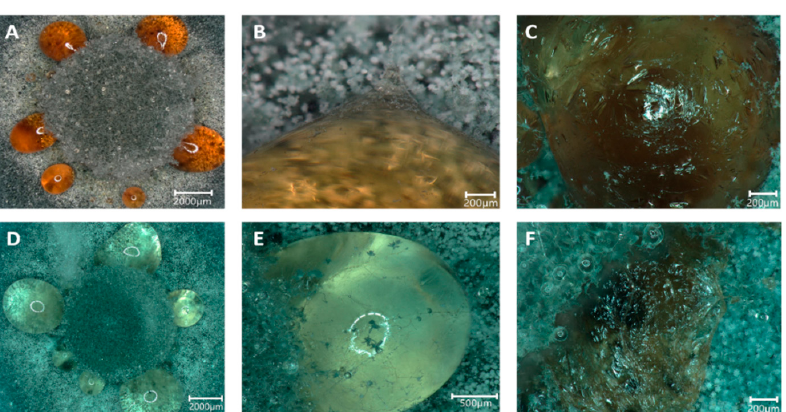
Figure 5. Guttation droplets occurring on MEA ( A – C ) and MEA amended with 25 mM SrCl 2 ( D – F ). The guttation droplets occurred in a ring surrounding the inoculum ( A , D ) and were overgrown by hyphae ( B , E ) which, after dehydration of the droplets, left a skin-like structure ( C , F ).